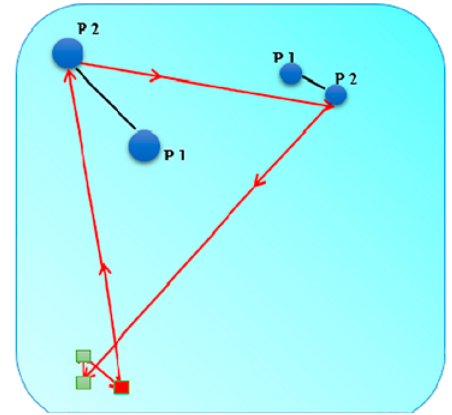
Fig. 2. Representation of moving objects